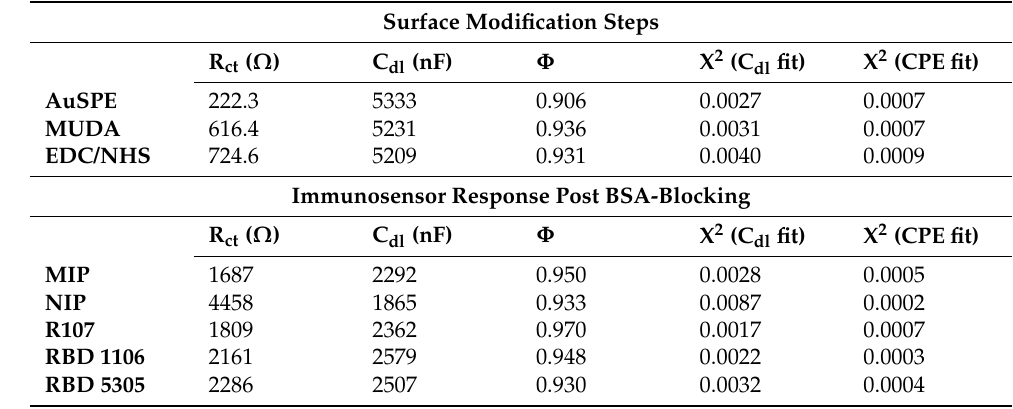
Table 1. Values of the equivalent circuit fitting of each surface modification step required for crafting the BioS with the recombinant antibodies, NanoMIP and NIPnps. The phase-shift angle ( Φ ) was extracted from each fitting concerning CPE modeling of the conducting/dielectric behavior of the electrode surface. Moreover, the X 2 parameter was used to evaluate the quality of each fitting. All resistances are in Ω and capacitances in